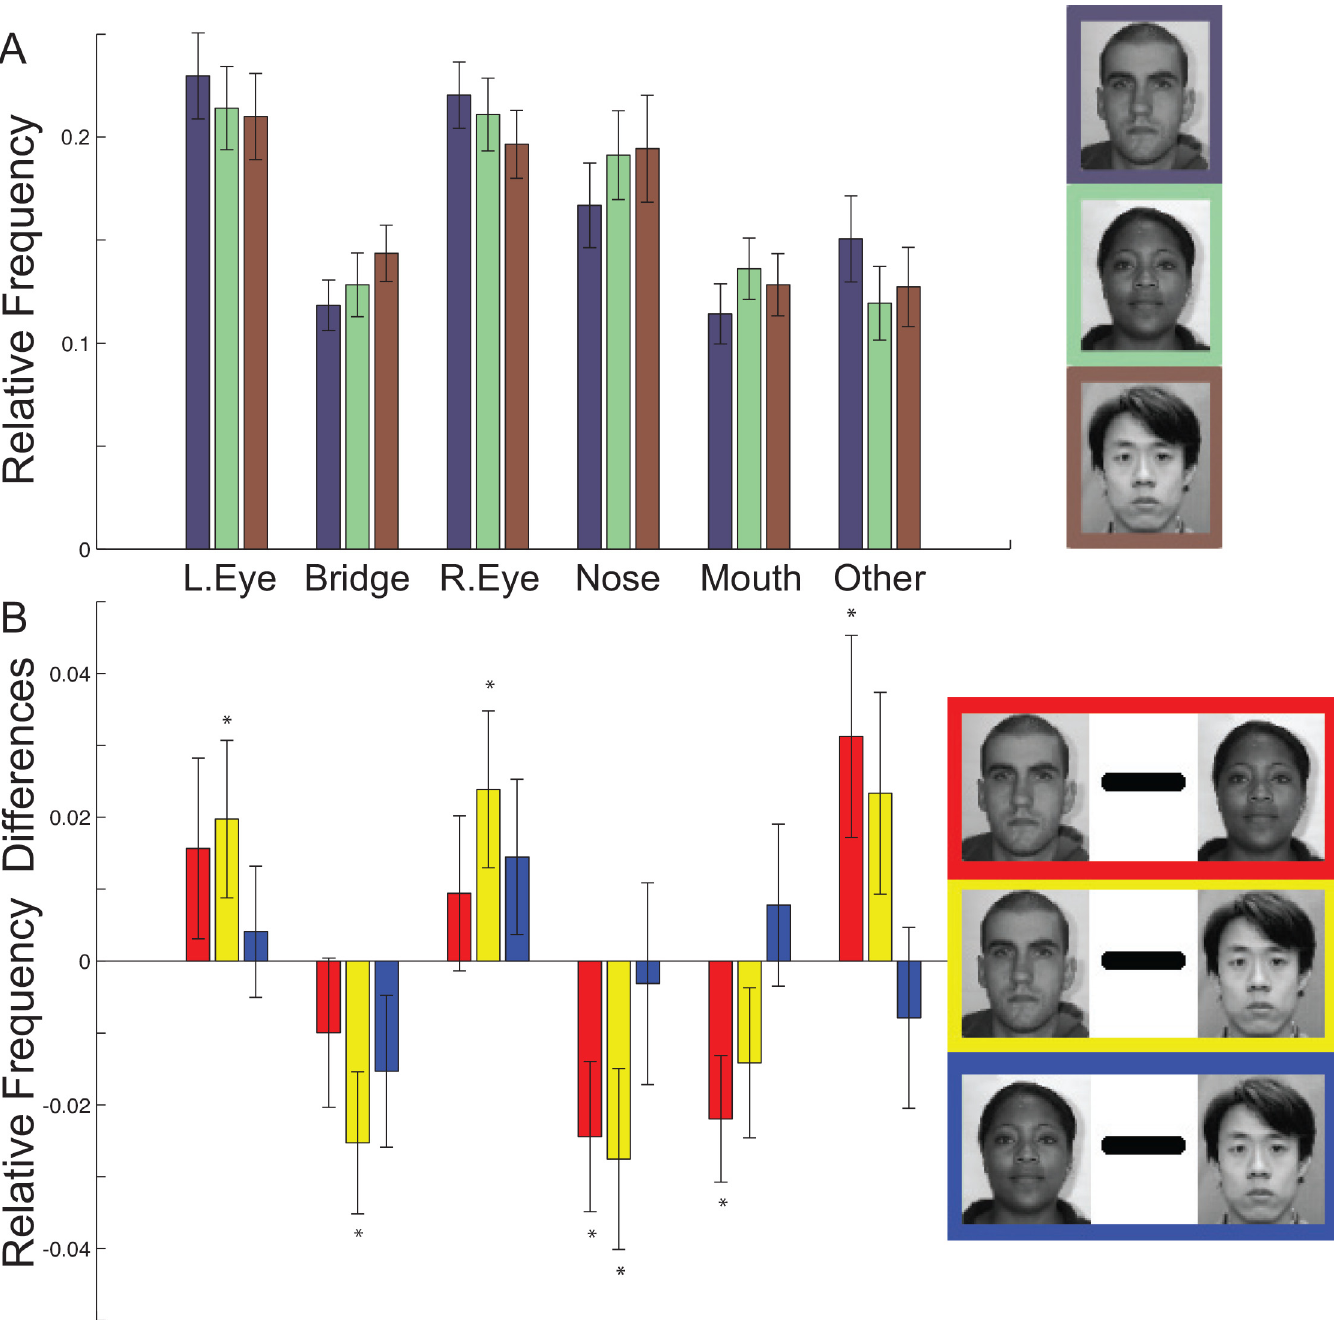
Fig 3. Distribution of fixations across AOIs for own- and other-race faces during the study phase. (a) Relative frequencies of fixations for each race of face across AOIs for the second through fifth fixations pooled. Error bars indicate between-subject standard errors. (b) Within-subject differences among race of face conditions from (a) reveal significantly more eye fixations for Caucasian than Chinese faces, significantly fewer nose fixations for own- than other-race faces, and significantly fewer mouth fixations for Caucasian than African faces. Error bars indicate the within-subject standard